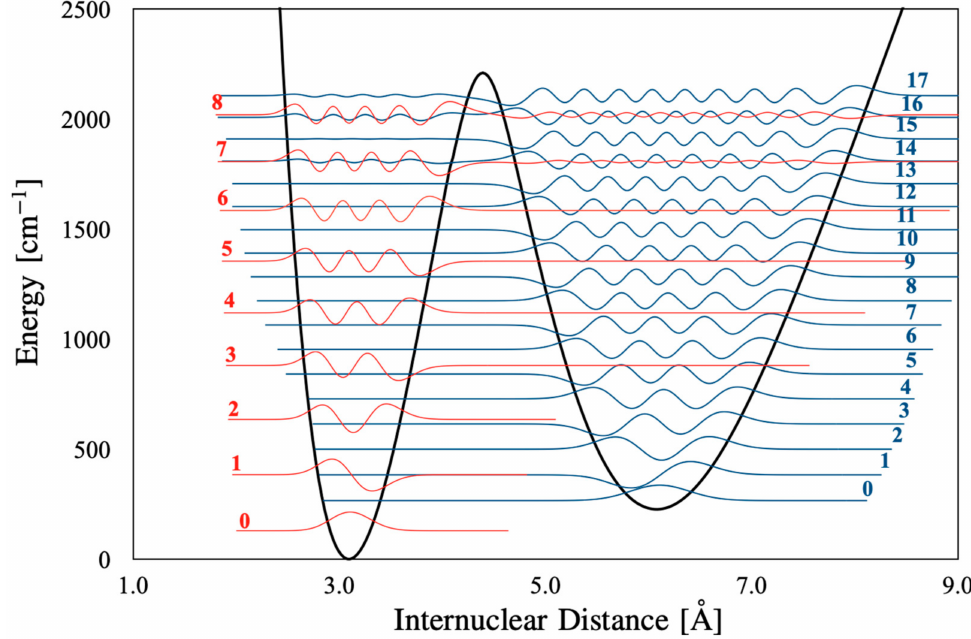
Figure 4. The eigenfunctions of vibrational levels v = 0–16 ( v i = 0–8 and v o = 0–17) for 2 1 Σ u+ (J = 0). The amplitudes are magnified by a factor of